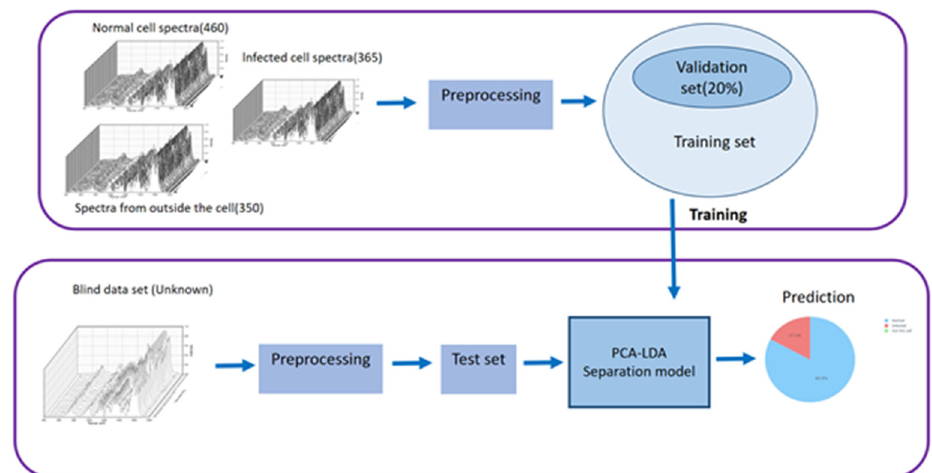
Figure 4. Flow chart of the discrimination analysis .